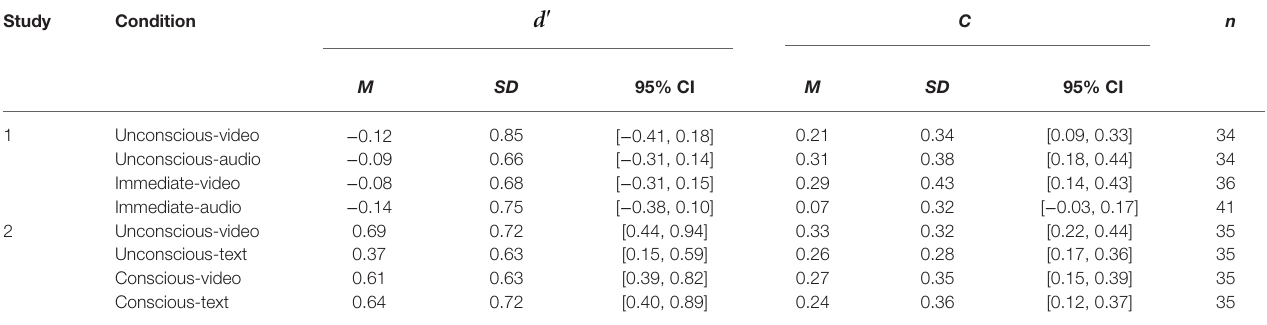
TABLE 2 | Means and standard deviations of d ¢ and C for all conditions in Study 1 and 2. Study